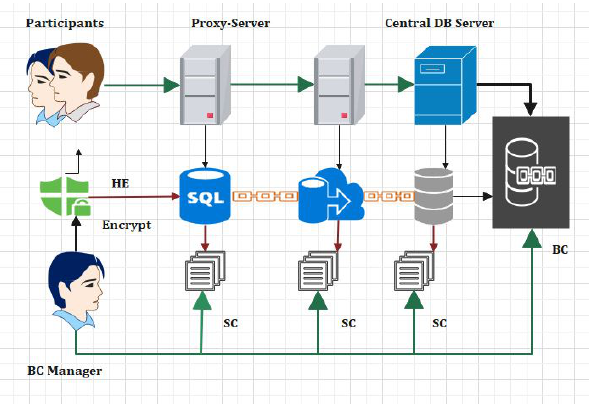
Figure 11. Working of Proposed Secure searchable framework.